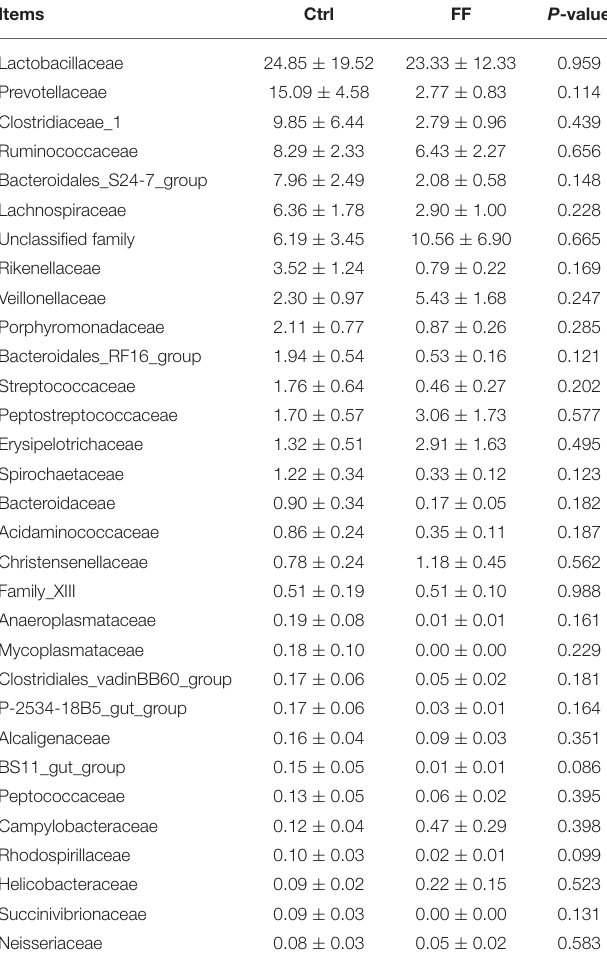
TABLE 5 | Relative abundance (percentage) for the top 30 most abundant family in the colonic mucosa-associated microbiota of pigs in the FF and control groups. Items Ctrl